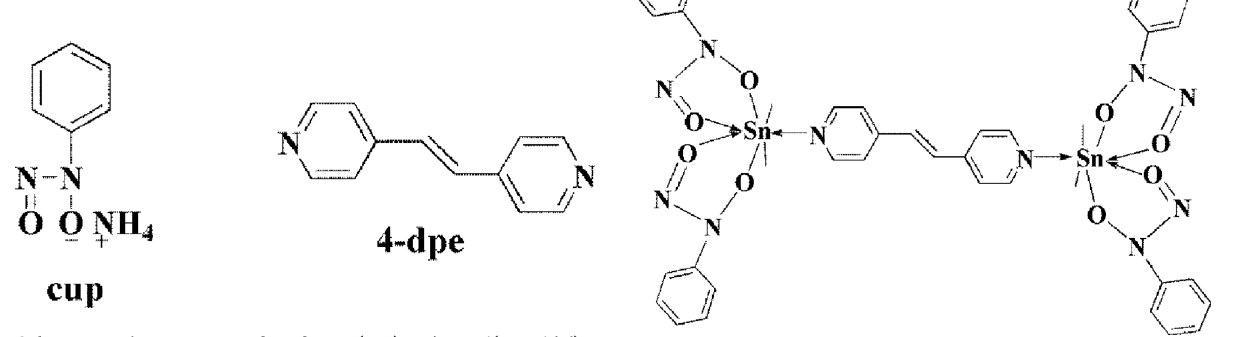
Scheme 2: Line drawing structure of tin